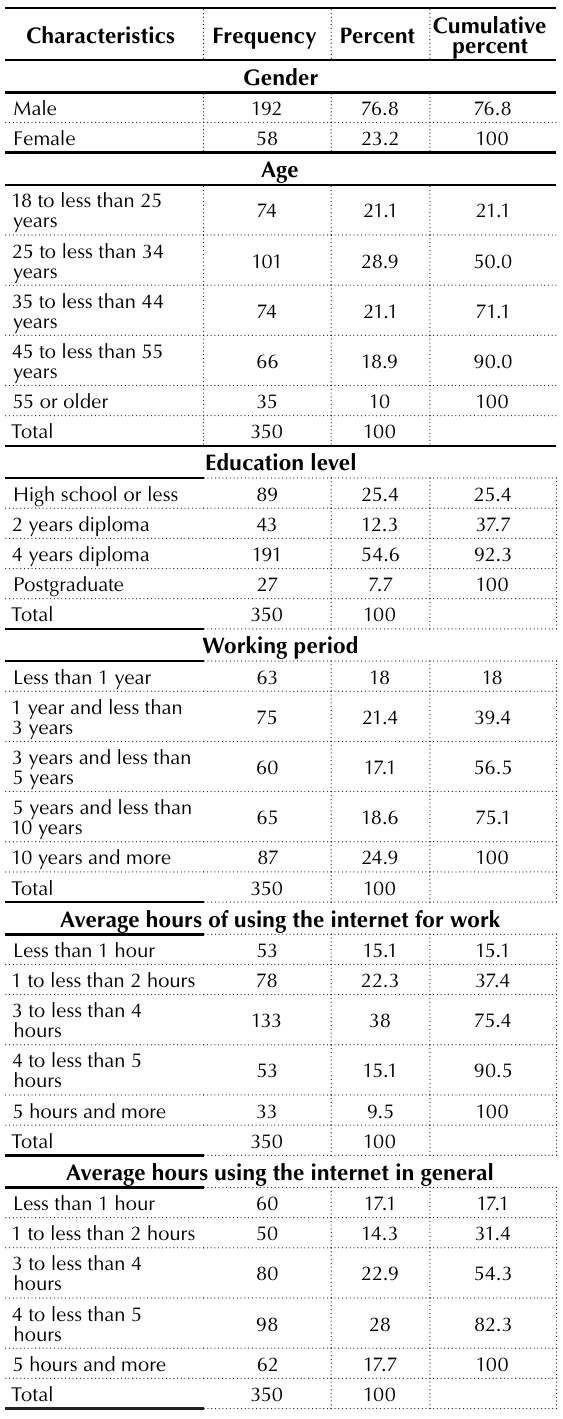
Table 2. Demographic